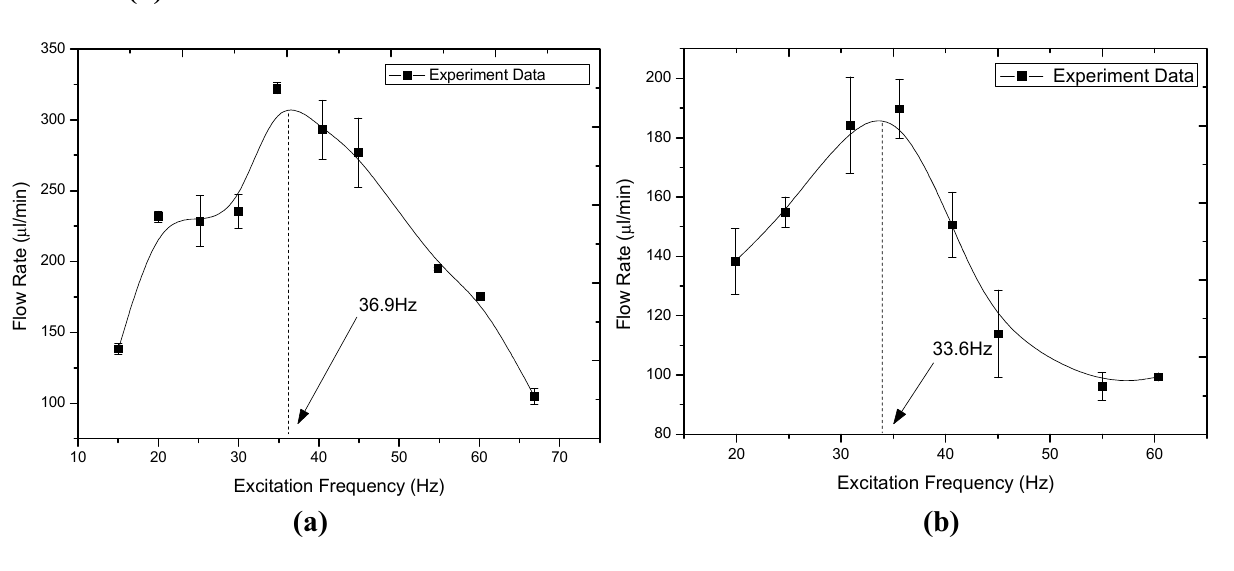
Figure 7. De-ionized (DI) water flow rates varying with frequency at currents of (a) 0.18 A and (b) 0.1